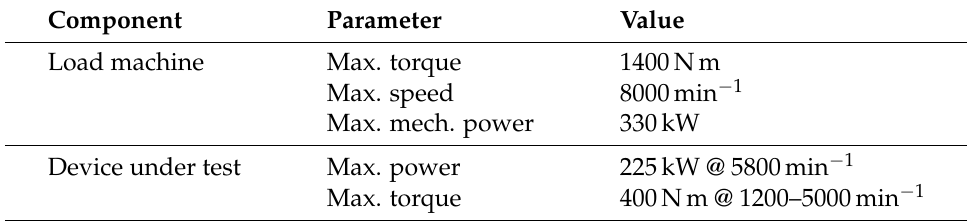
Table 4. ICE test bench system